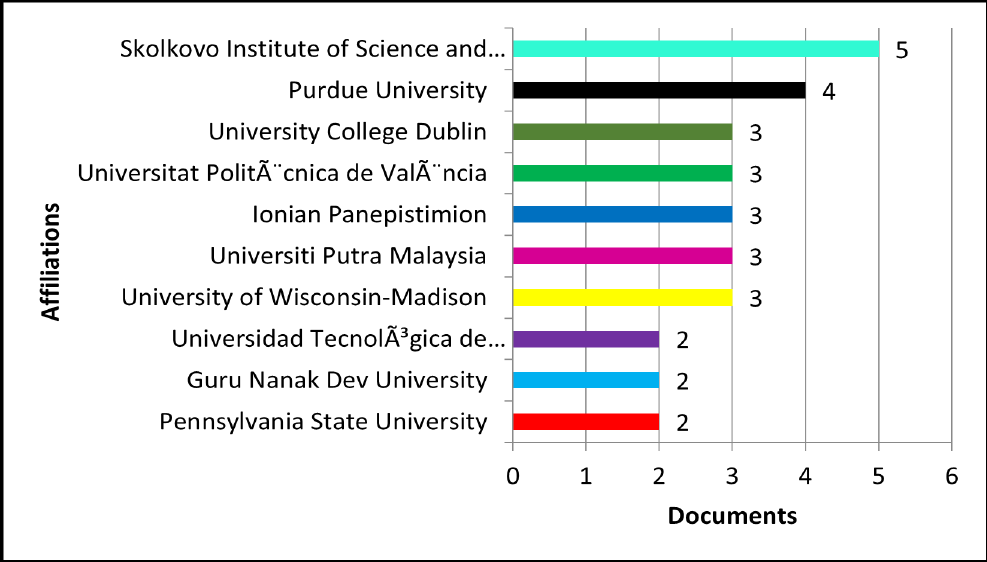
Figure 9. Statistics of affiliation for IoT in agriculture.